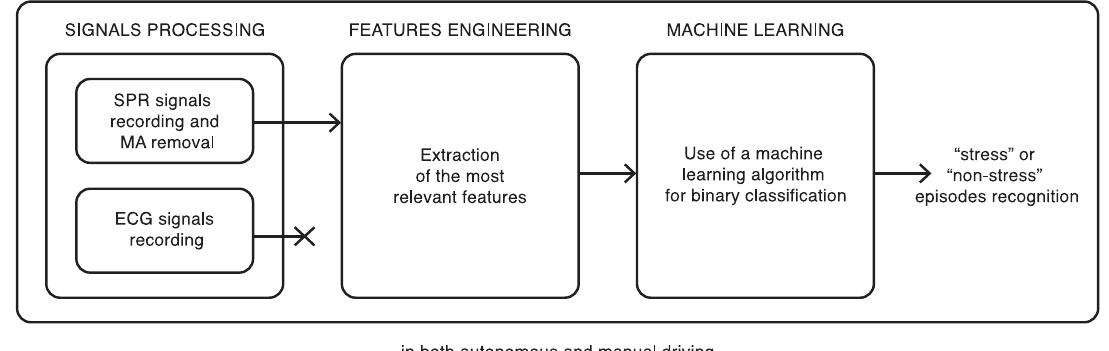
Figure 1. The proposed scheme: the processing blocks are the same in both the manual and autonomous driving